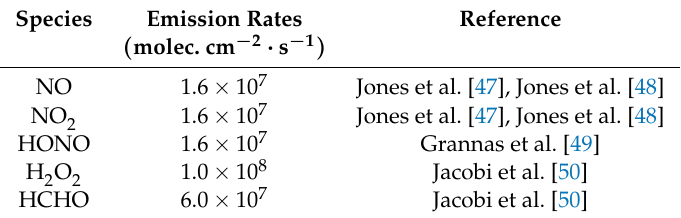
Table 2. Emission fluxes from the ice/snow-covered ground surface, adopted from Cao et al.